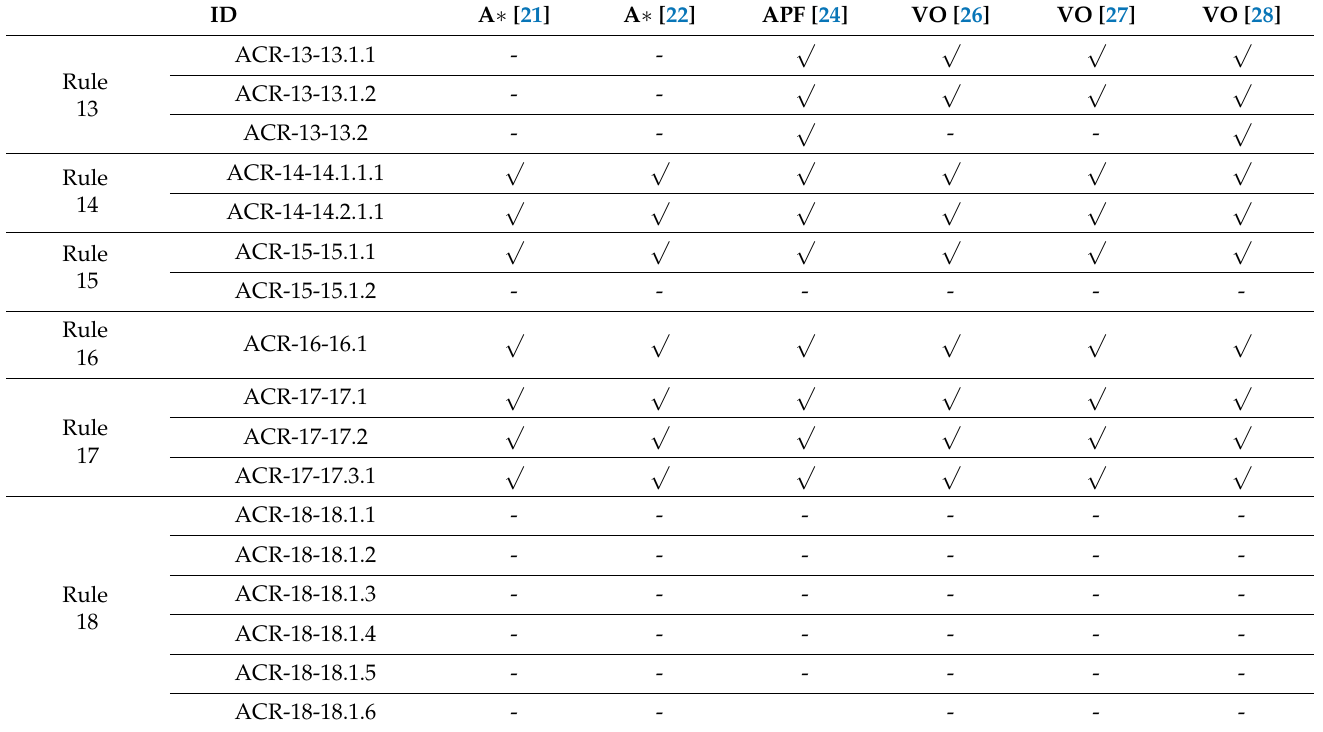
Table 13. Validation for requirements specifications of ship anti-collision responsibility (give-way